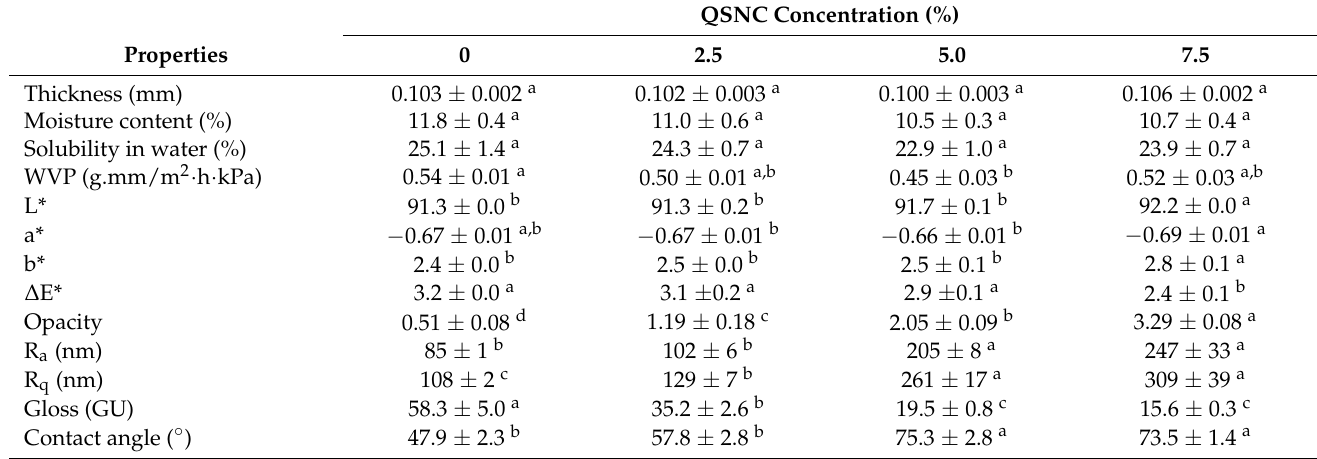
Table 1. Thickness, moisture content, solubility in water, water vapor permeability (WVP), color parameters, opacity, average roughness (R a ), root mean square roughness (R q ), gloss and